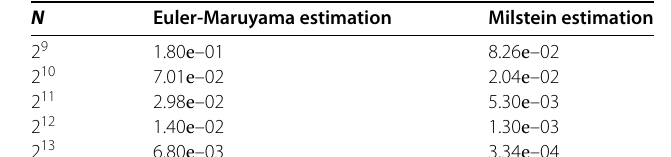
Table 2 Calculated mean square errors for Euler-Maruyama and Milstein methods N